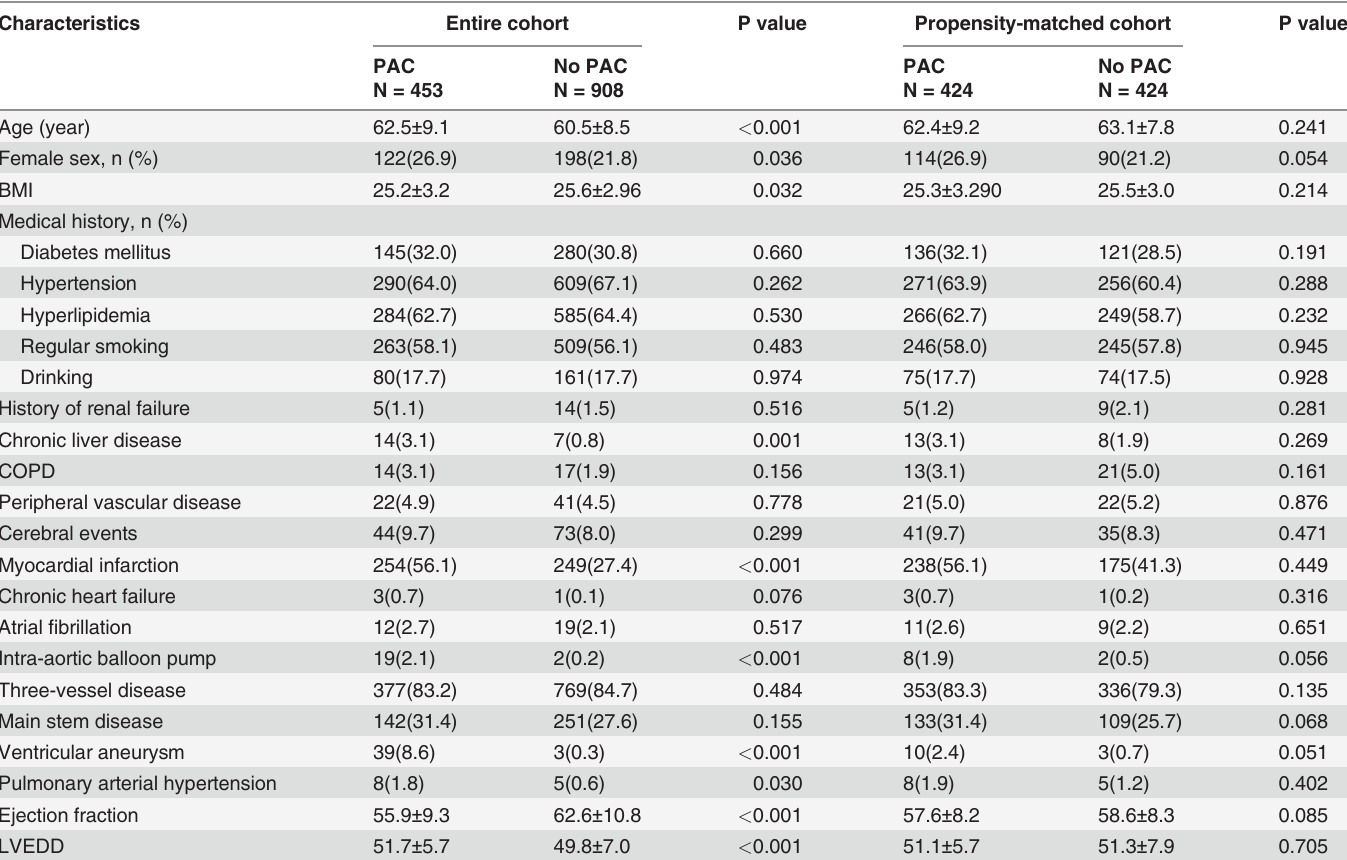
Table 1. Baseline